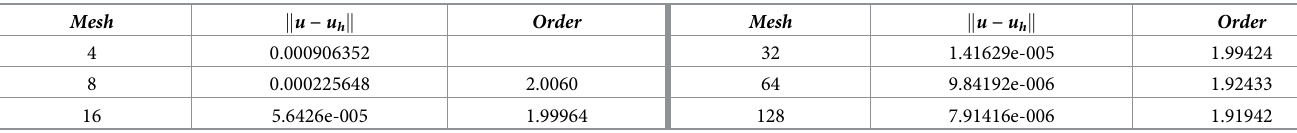
Table 2. Error profile and convergence rate for the Experiment 2. Mesh